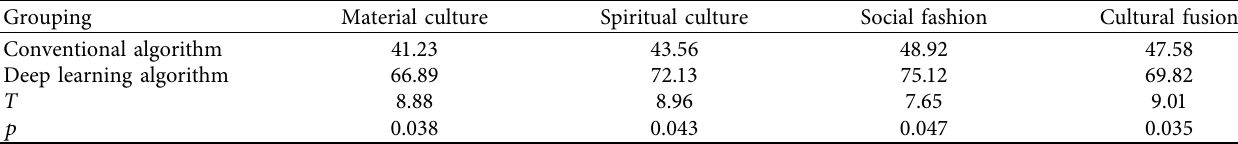
Table 1: Coupling degree of the Dunhuang murals and modern costumes under different algorithms.